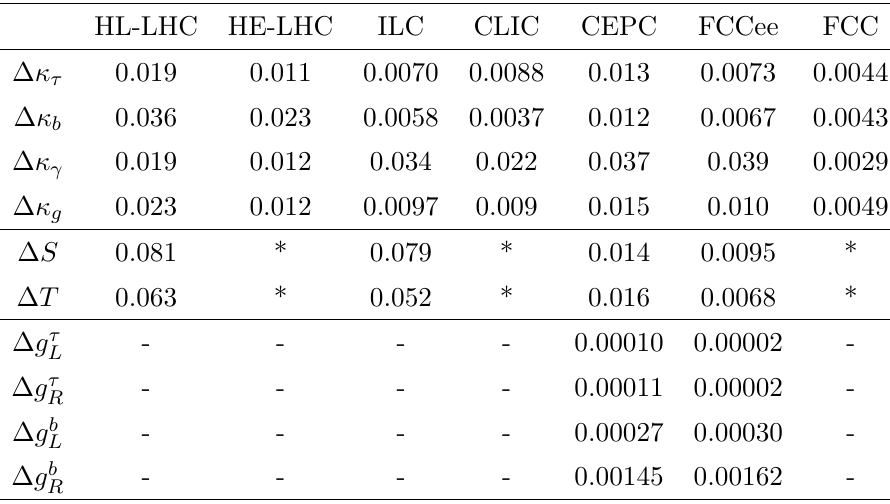
Table 9. Projected sensitivities used in this analysis. Projections for κ τ , κ b , κ γ and κ g come from [54], those for S and T come from [50] (see text) and all others from [55]. The symbol “*” indicates no known reliable estimate while the symbol “-” indicates no significant improvement in